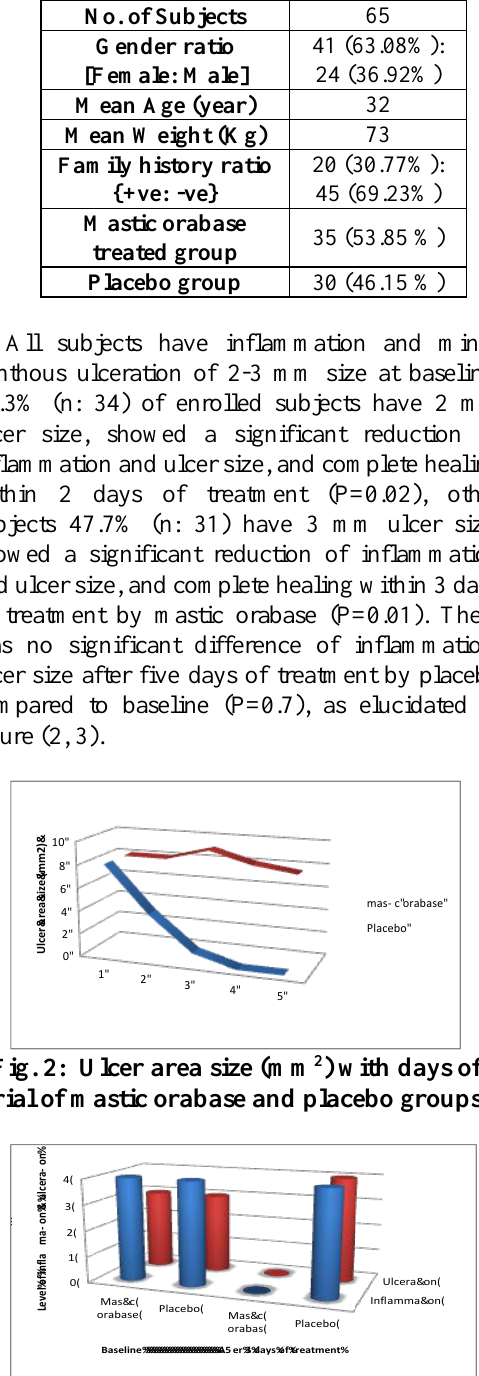
Table 2: Subjects’ characteristics